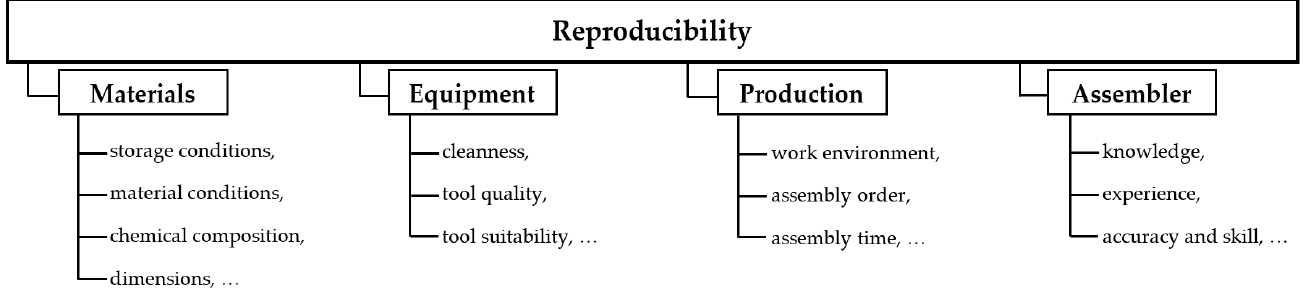
Figure 3. Input variables influencing the reproducibility.